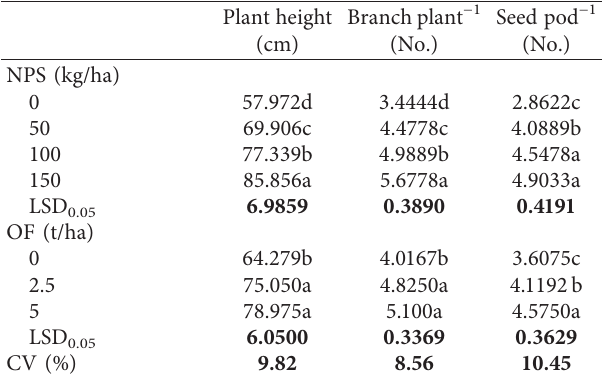
Table 2: Plant height, branches per plant, and seeds per pods affected by NPS and organic